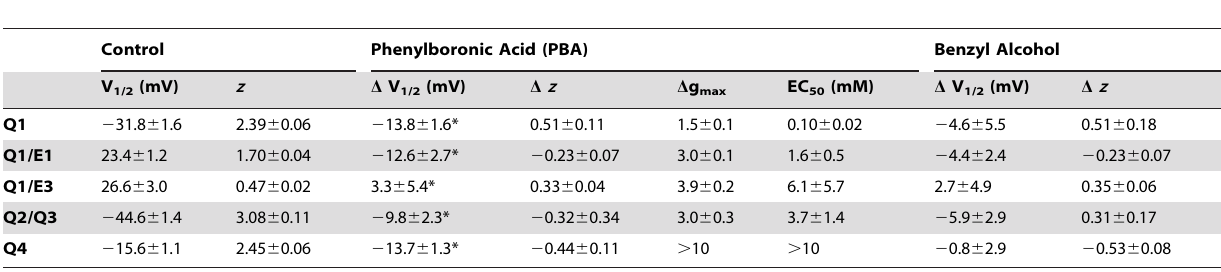
a Data from individual activation curves obtained from 4–10 oocytes. Activation curves were fit to a Boltzmann function. V K is the voltage of half-maximal activation and z is the slope factor. D V 1/2 and D z are the changes induced by addition of 10 mM compound. D g max values were determined during the washout of inhibition, as described in the Materials and Methods. EC 50 values were determined during the washout of inhibition for PBA concentrations ranging from 1–10 mM. All values are mean 6 SEM except for EC 50 values, which are reported as the error of the fit to a hyperbola. * Indicates significant (Student t -test; p , 0.05) when compared to benzyl alcohol.